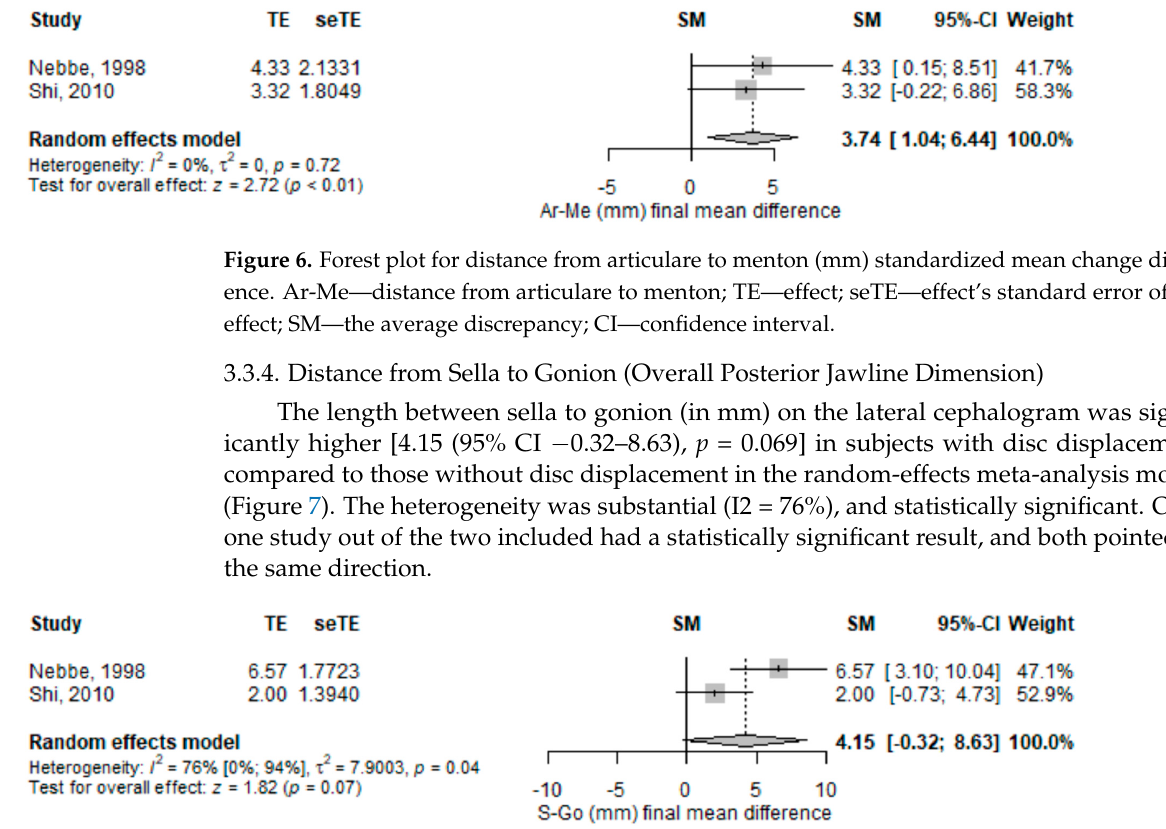
Table 2. Meta ‐ analyses results.